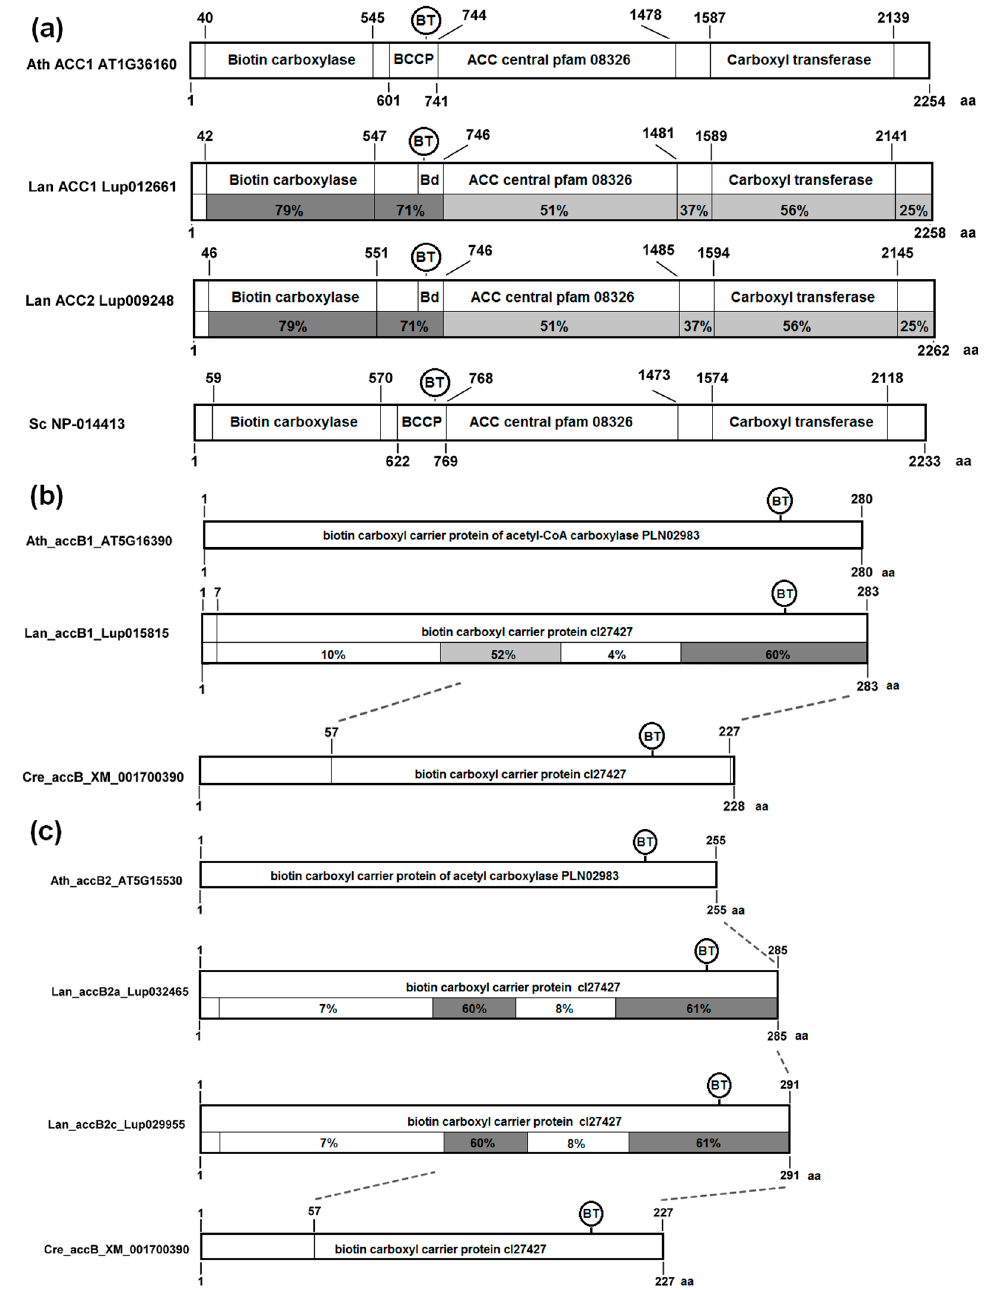
Figure 3. The structure of cytosolic acetyl-coenzyme A carboxylase (ACCase) and biotin carboxyl carrier protein (BCCP) subunits of plastid ACCase. ( a ) cytosolic ACCase gene; ( b ) plastid subunit accB1 gene; ( c ) plastid subunit accB2 gene. Amino acid positions and sequence conservation values are provided. Blocks are colored according to sequence conservation level, namely: white, 4–19%; light grey, 20–59%; dark grey, 60–79%; black, 80–100%. Legume sequences used for calculation are provided in the Tables S11, S13 and